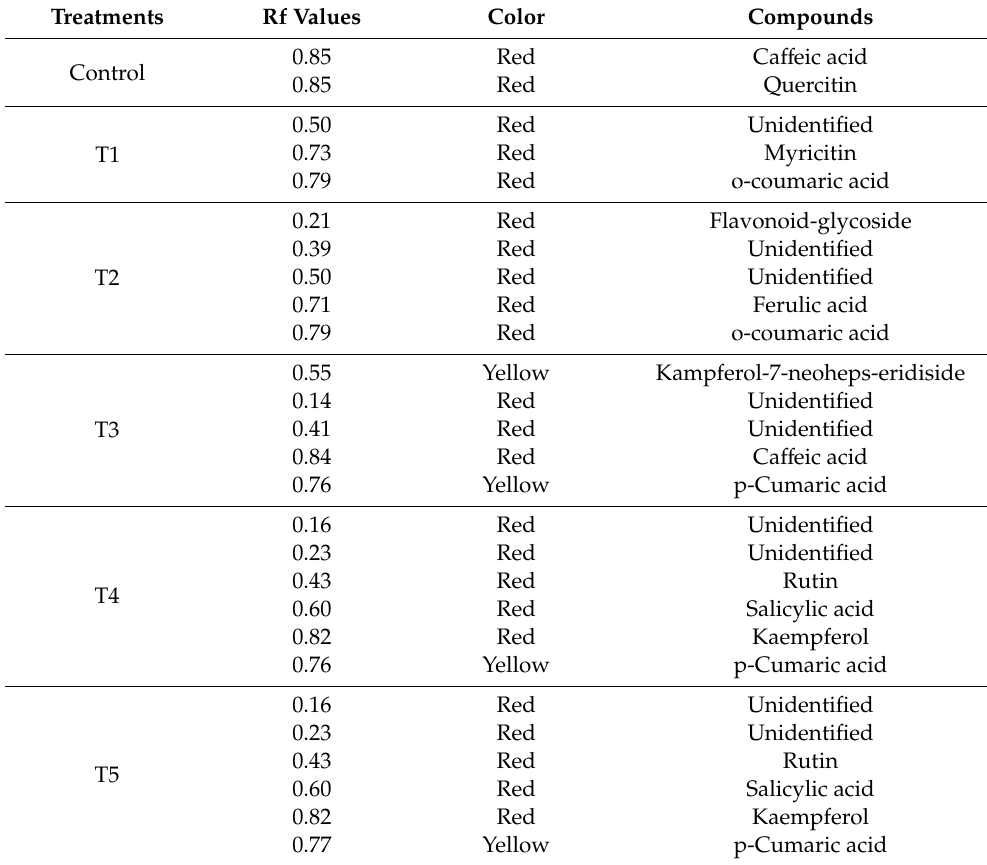
Table 1. Putative secondary metabolites identified on the basis of the Rf values in the extract of tomato leaves of di ff erent